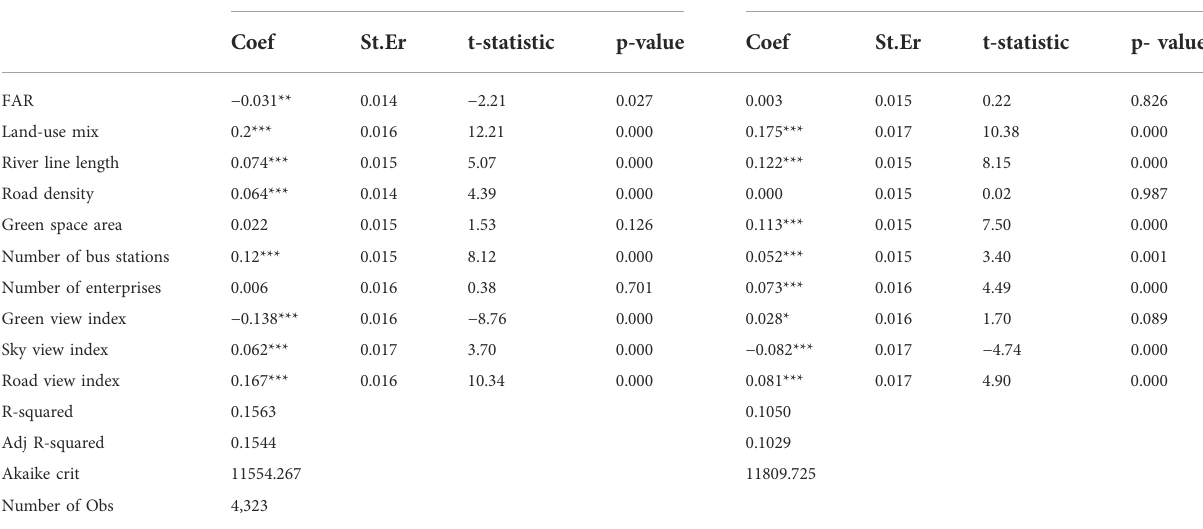
TABLE 3 OLS modeling